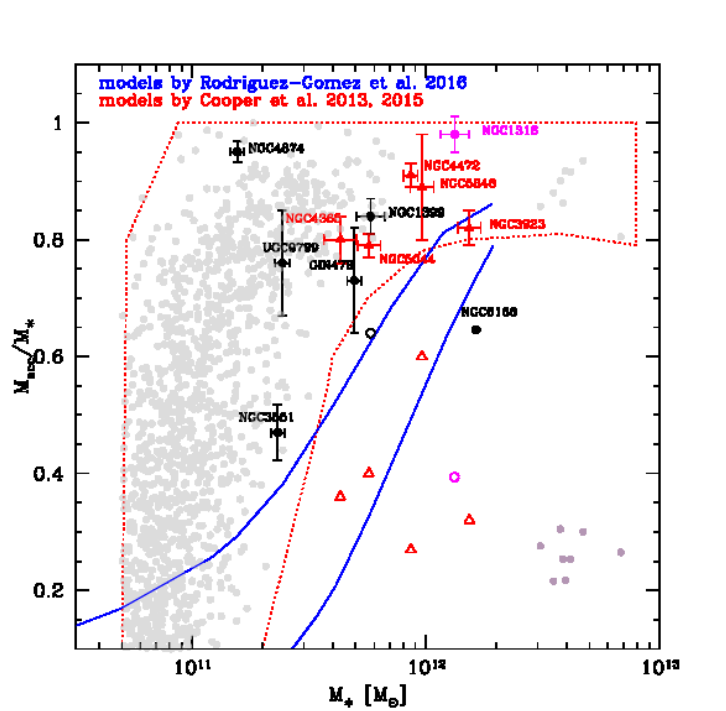
Figure 3. Accreted mass fraction vs. total stellar mass for early-type galaxies (ETGs). Our VST Elliptical GAlaxies Survey (VEGAS) measurements are given as red filled and open triangles (see text for details). Black circles correspond to other BCGs from the literature [10,13,18]. Pink points are for NGC1316 [19]. Red and blue regions indicate the predictions of cosmological galaxy formation simulations by [3,17] and Rodriguez-Gomez et al. [4], respectively, while grey points are from Cooper et al. [3]. Purple-grey points (between 3 × 10 12 and 7 × 10 12 solar masses) show the mass fraction associated with the streams from Table 1 in Cooper et al. [17] for comparison to the observations shown by open